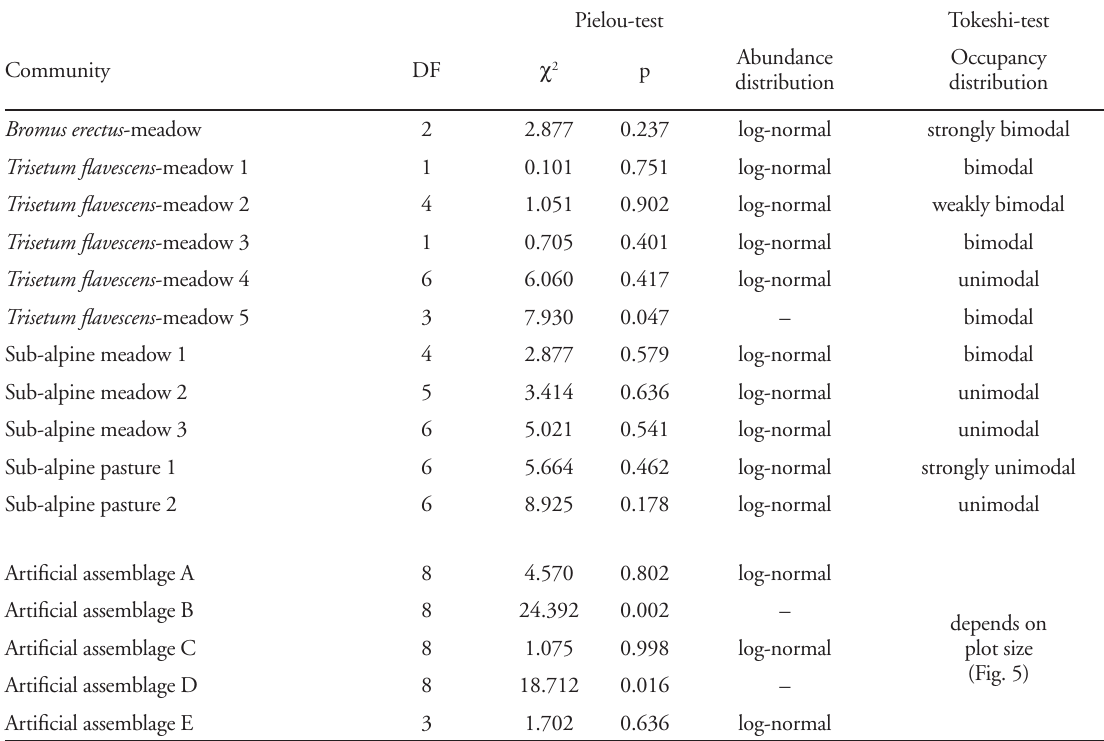
Table 4. Goodness of fit ( χ 2 test, p < 0.05) of the expected values of a truncated log-normal distribution to the distribution of observed cover values of the species in 11 plant communities (ten quadrats per community, quadrat size 1 m 2 ), and to the distribution of in- dividual numbers of the species of five artificial assemblages, respectively. The fitting was performed following the procedure given in Pielou (1975). The fifth column indicates the shape of the occupancy distribution for the plant communities using the test procedure of Tokeshi